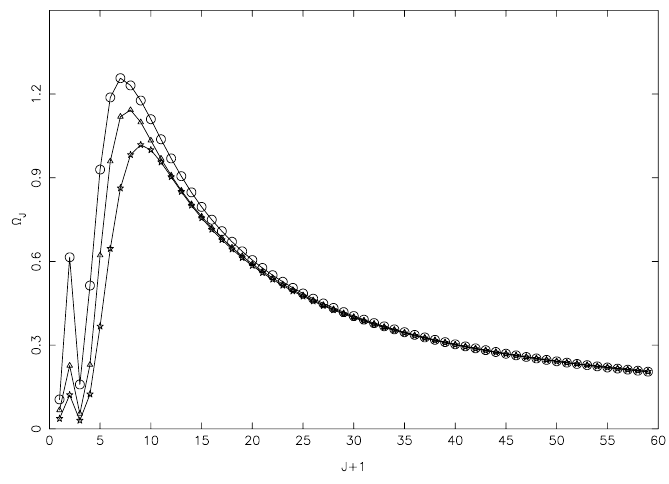
Figure 1. Partial collision strengths for the 2s 2 S 1/2 –2p 2 P o of: 4 Ryd (circles), 6 Ryd (triangles) and 8 Ryd (stars).